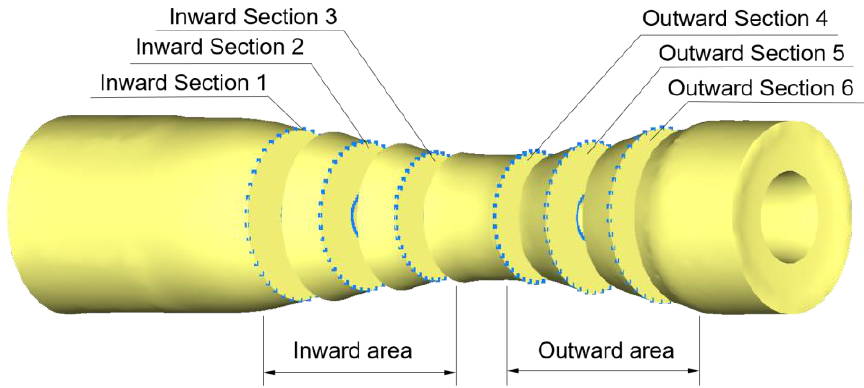
Figure 7. Sections and post-processing picking